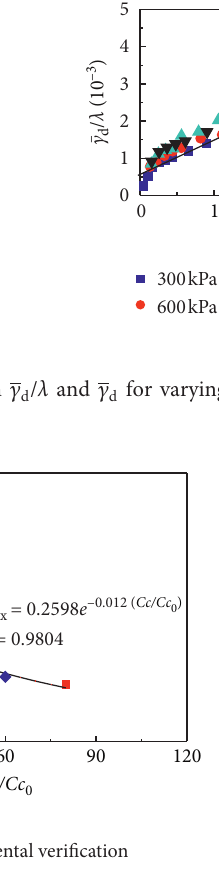
and the cementing agent content. max